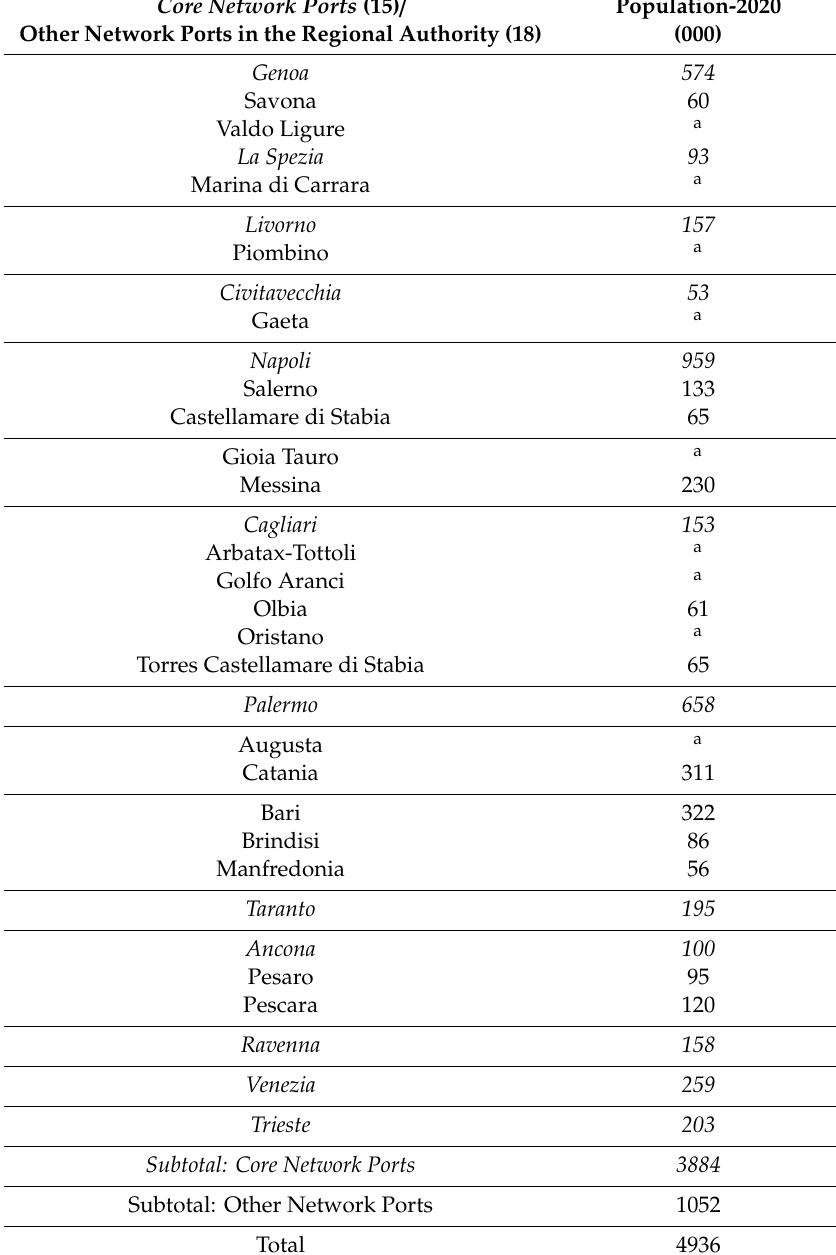
Table 5. Human populations in Italy’s